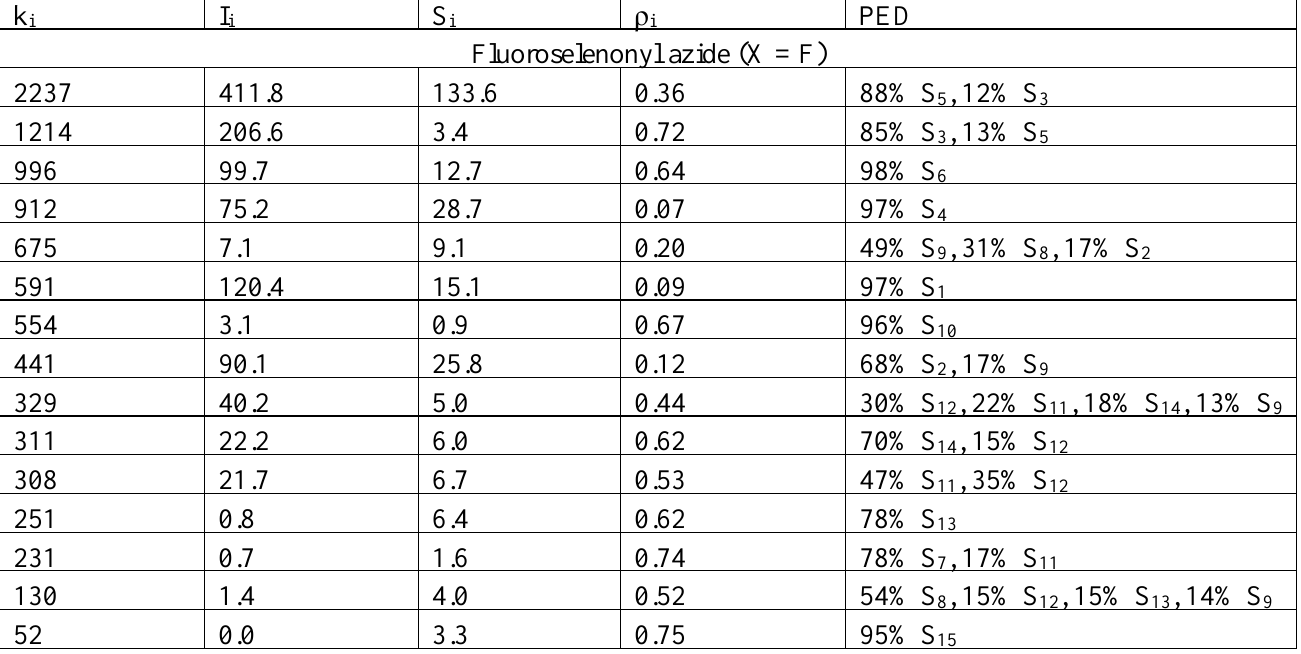
DFT wavenumbers, k in cm -1 (all symmetry species are A), infrared intensities, I i in km mol -1 , Raman activities, S in Å 4 amu -1 , depolarization ratios ρ i bution of the potential energy of a normal mode in the symmetry coordinates, PED (only values larger than 10% are given), for the normal modes i in halo-